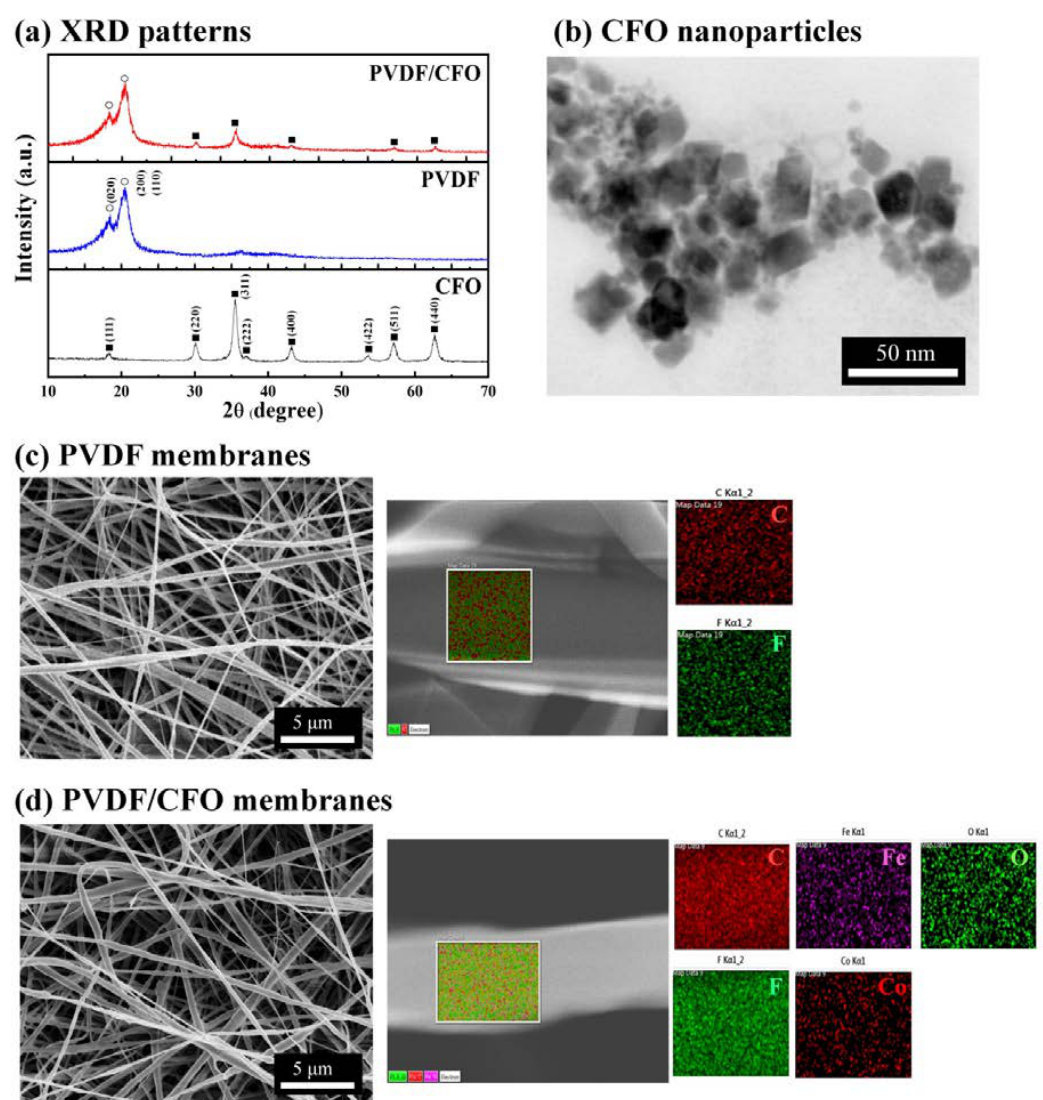
Figure 2. ( a ) X-ray diffraction (XRD) patterns of CFO nanoparticles, PVDF membranes, and PVDF/CFO membranes, ( b ) a transmission electron microscope (TEM) image of CFO nanoparticles, ( c ) a scanning electron microscope (SEM) image with energy dispersive spectrometer (EDS) analysis of PVDF membranes, and ( d ) an SEM image with EDS analysis of PVDF/CFO membranes. As shown in Figure 3, the piezoelectric output voltage of the PVDF/CFO membranes was